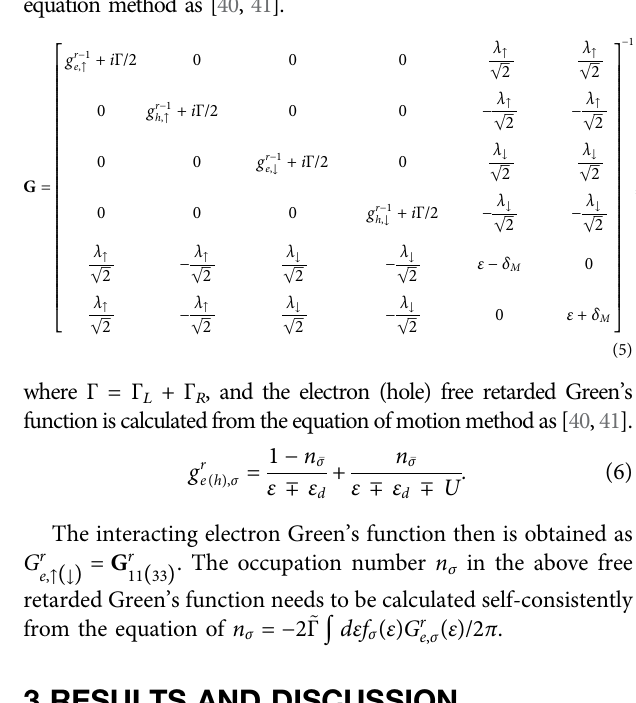
FIGURE 1 | The spin-up electrical conductance G ↑ in (A) , and thermopower S ↑ in (B) asfunctionsofthedotlevel ε d forindicatedparameters, respectively.Duetothearrangementof λ σ , G ↑ , P (cid:1) 0 (cid:1) G ↓ , P (cid:1) 1 , G ↑ , P (cid:1) 1/4 (cid:1) G ↓ , P (cid:1) 3/4 , and G ↑ , P (cid:1) 1/2 (cid:1) G ↓ , P (cid:1) 1/2 . The same holds true for the thermopower, and then we only illustrate the results of spin-up component.